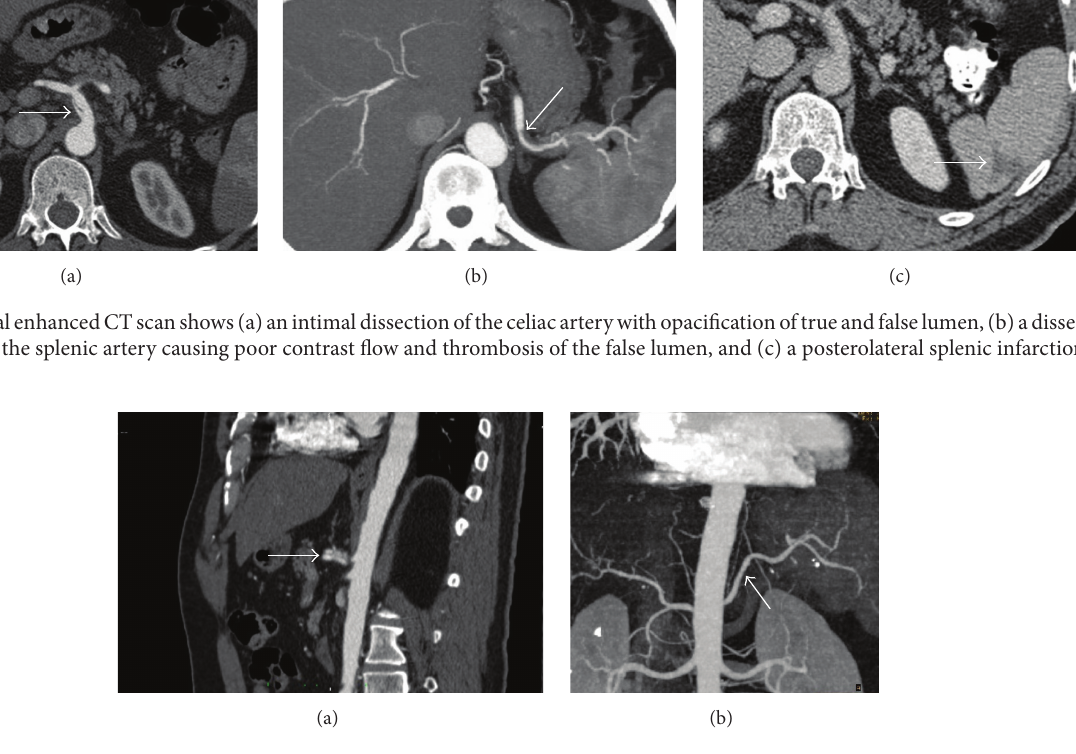
Figure 2: Control CT scan after one month. (a) Sagittal contrast-enhanced CT scan shows ectasia of the celiac artery and stability of intimal dissection compared to the previous scan. (b) 3D reconstruction of the aorta and branch vessels shows patent splenic